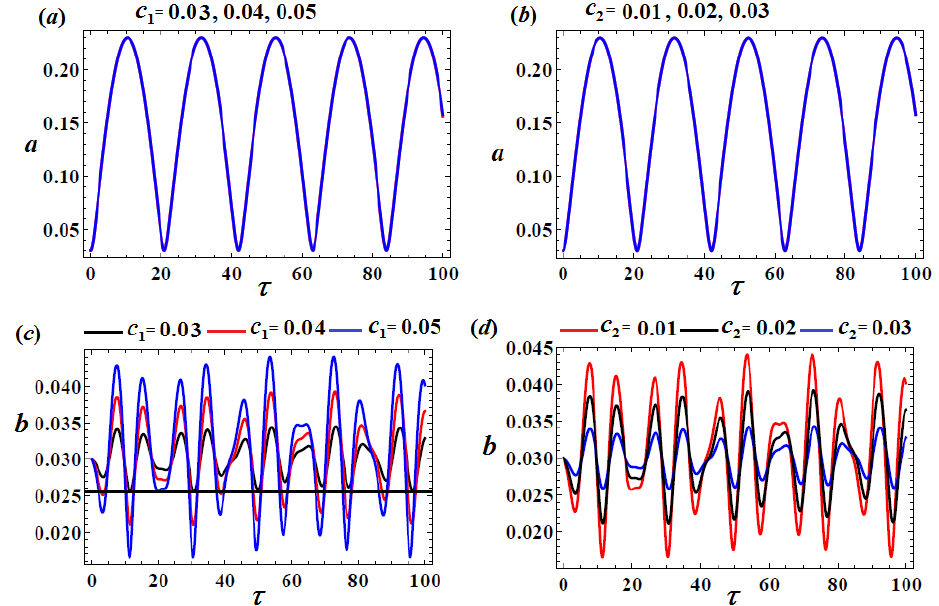
2 (= 0.01,0.02,0.03) c m − on the ampli- 2